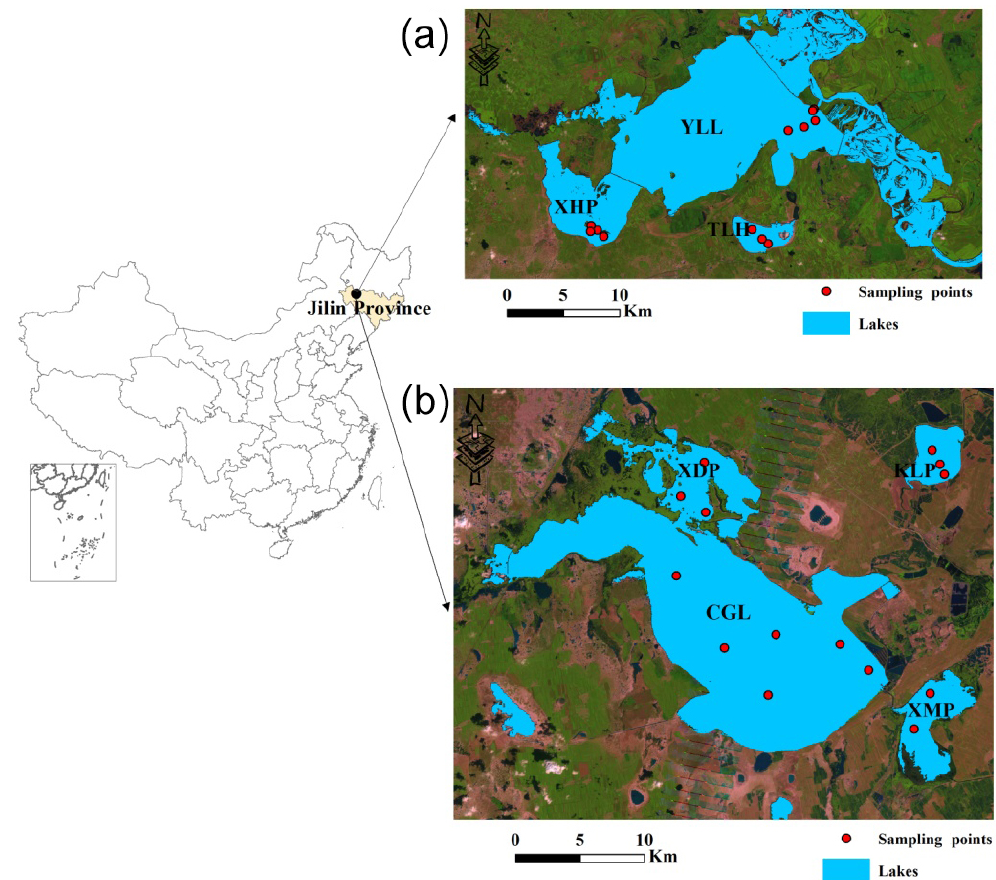
Figure 1. Locations of the water sampling sites for seven lakes in the western part of the province of Jilin, Northeast China. (a) Yueliang lake group: YLL, Yueliang Lake; XHP, Xinhuangpao; TLH, Talahong; (b) Chagan lake group: CGL, Chagan Lake; XDP, Xindianpao; XMP, Xinmiaopao; KLP,